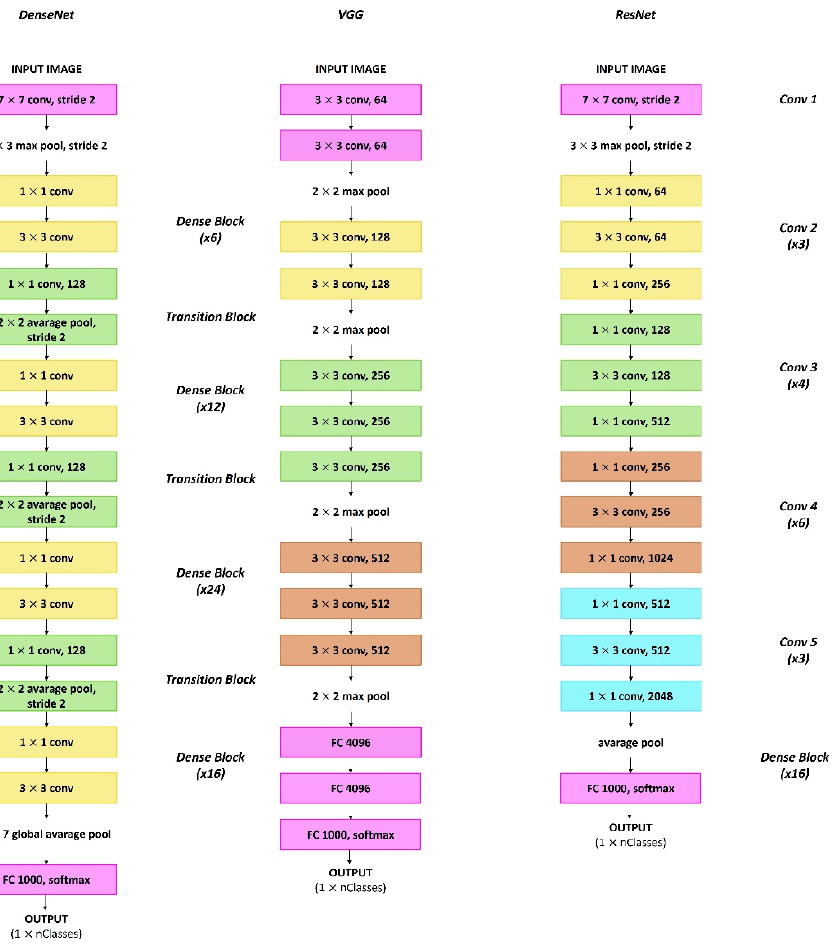
Table 3. Main characteristics of the experiments performed by applying the three classi fi cation algorithms to the four multiband rasters.